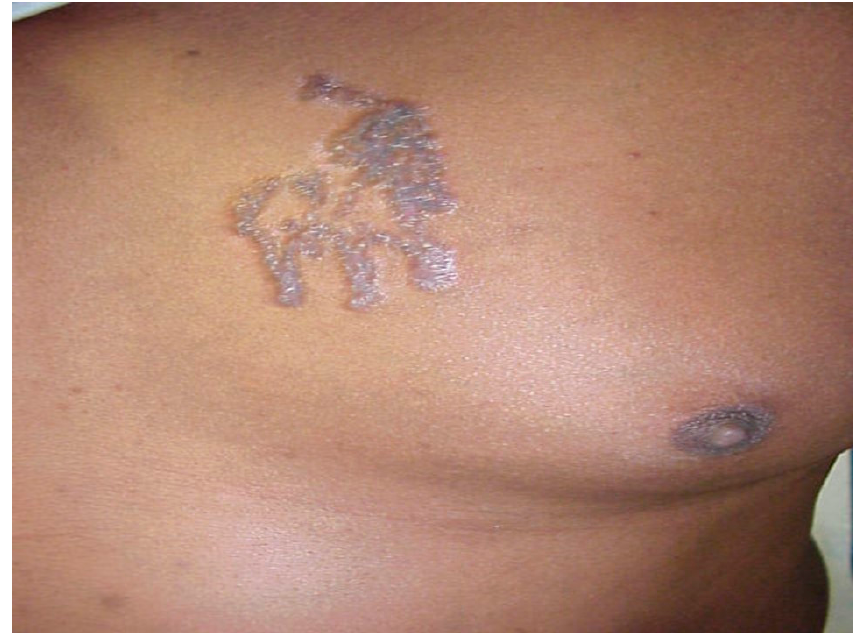
Figure 6. Tattoo of a sarcoidosis patient that was completely replaced by granulomatous inflammation.